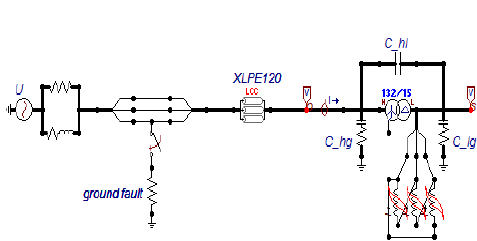
Fig. 1.a. Studied power system.